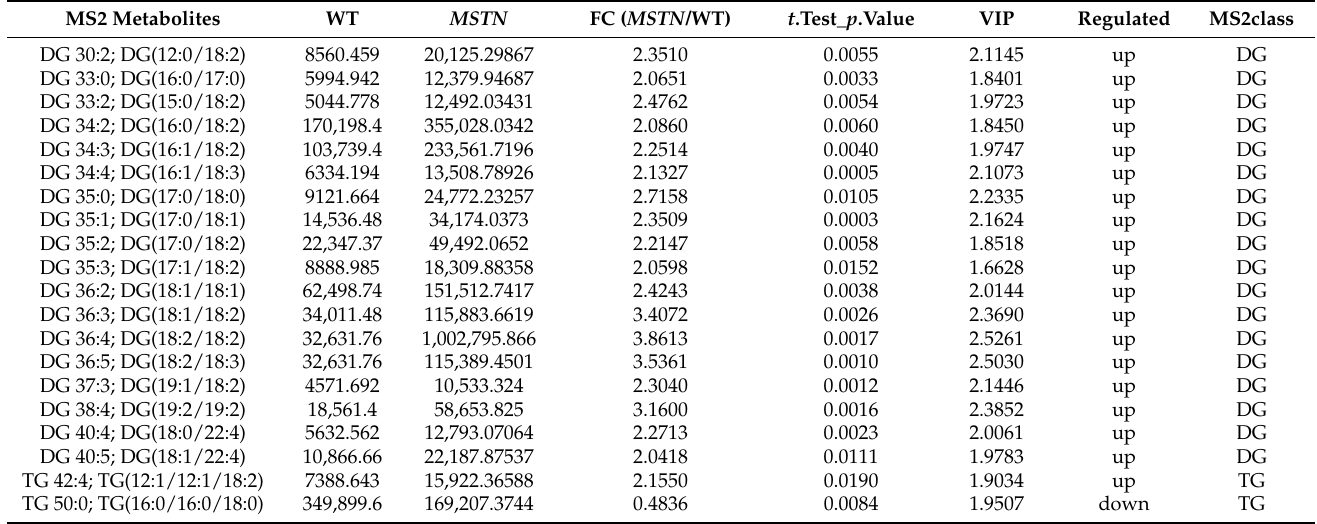
Table 3. Significantly differently expressed glycerolipids in the MSTN +/ − versus the WT pigs.